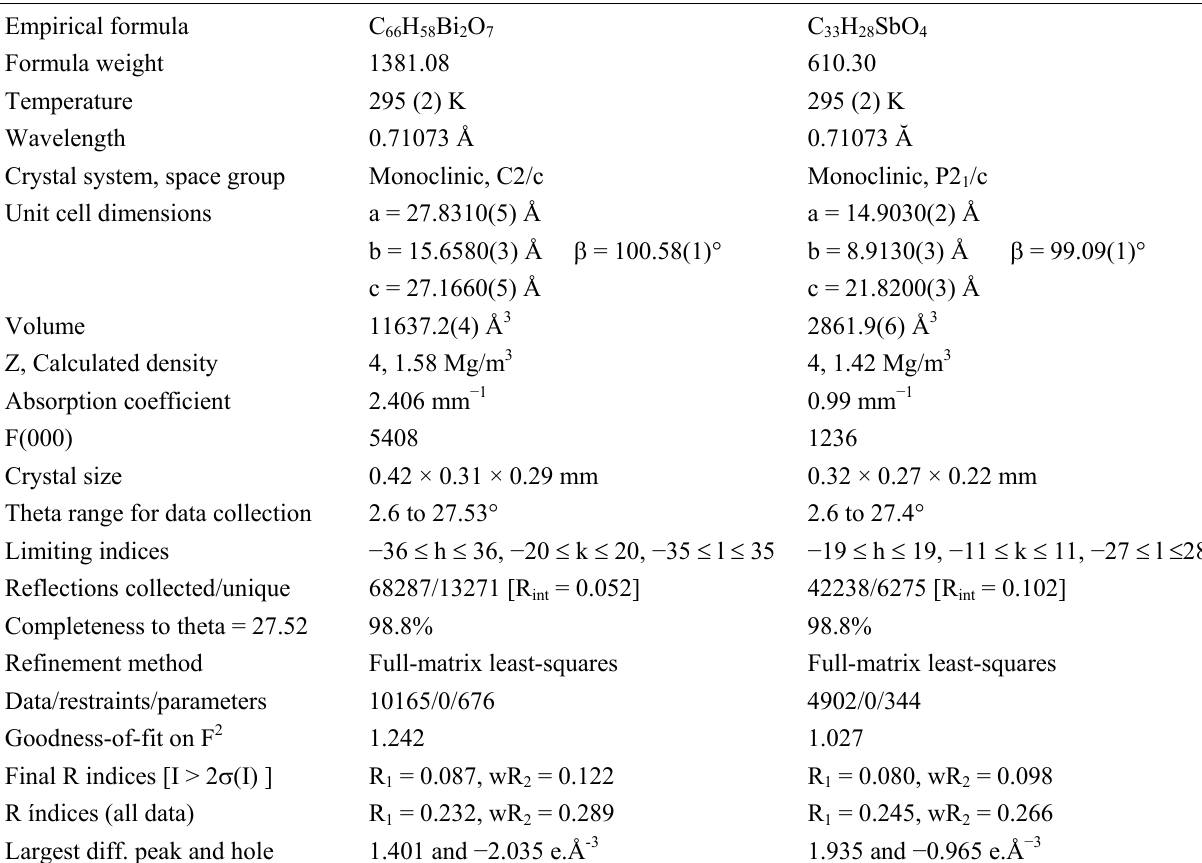
Table 2. Crystal data and structure